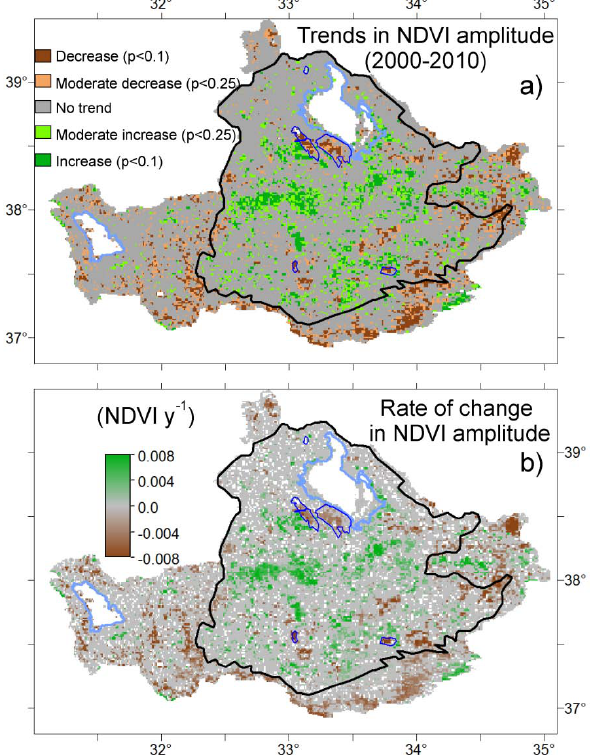
Fig. 11. The distribution of (a) water limitation (b) the correlation between P and ET in the